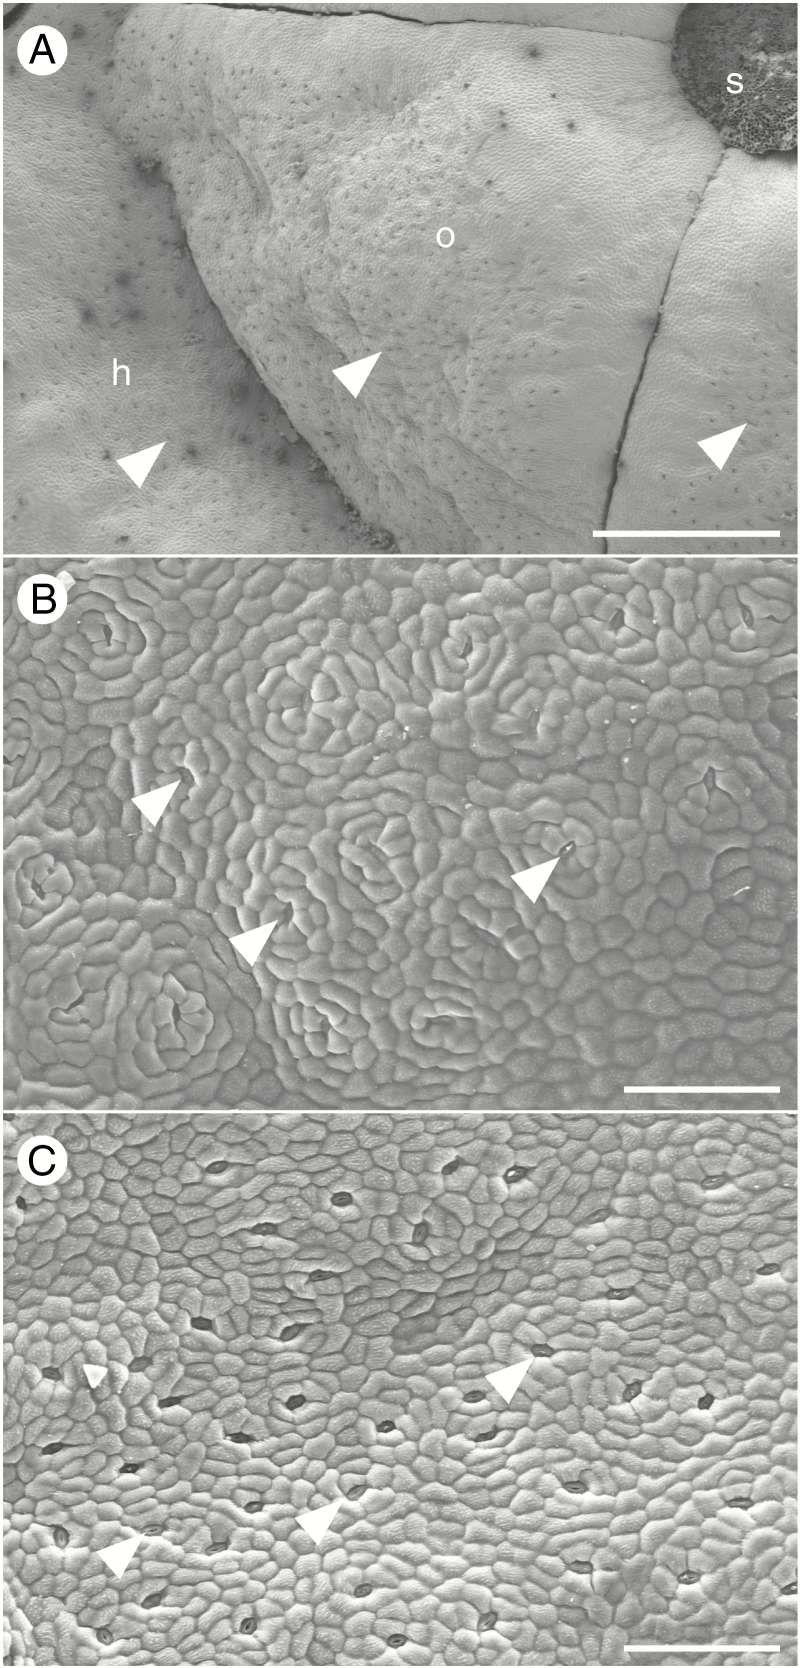
SEM micrographs of the nectary surface of nectar-secreting mānuka flowers at Stage 3. (A) Base of the excised style (s), upper surface of the ovary (o) and inner wall of the hypanthium (h) of an NT flower. Modified stomata (arrowheads) are visible on the ovary and hypanthium surface. (B,C) Examples of variation in the density of modified stomata (arrowheads) between genotypes (B, MI; C, WK) Scale bars = 500 µm in A, 100 µm in B and C.